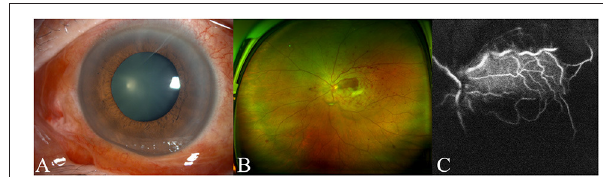
FIGURE 1 | The findings of anterior segment image, fundus image, and fundus fluorescein angiography. Anterior segment photograph shows conjunctiva congestion and a 6-mm fixed pupil (A) . Fundus image reveals scattered retinal hemorrhage and retinal whiting with one small area of the normal-appearing retina temporal to the optic disk (B) . Fundus fluorescein angiography 40s after injection of the dye showed rapid filling of one cilioretinal vessel and delayed filling of the central retinal artery (C)